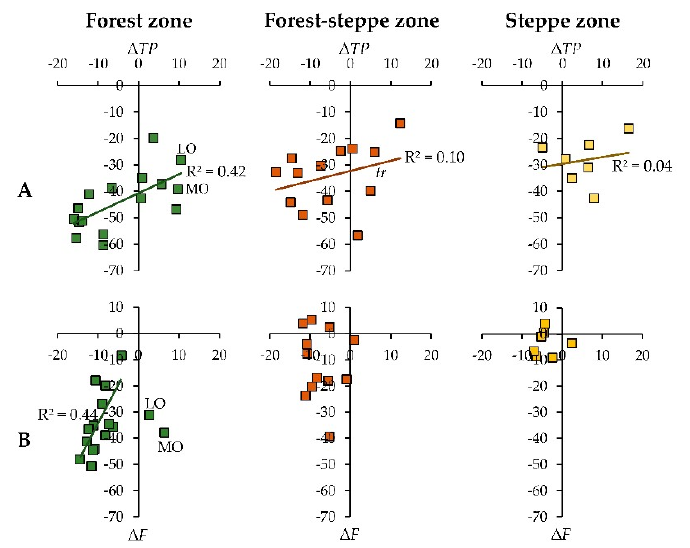
Figure 10. The ratio between relative changes in the total population ( ∆ TP , %) and the total area of cultivated land ( ∆ F , %) by the analyzed administrative regions in the landscape zones of European Russia: ( A ) between 1970–1987 and 1996–2017, ( B ) between 1996–2004 and 2005–2017; R 2 —the coefficient of determination of a linear trend ( tr ). LO—the Leningrad Oblast, MO—the Moscow Oblast (see Figure 2A).